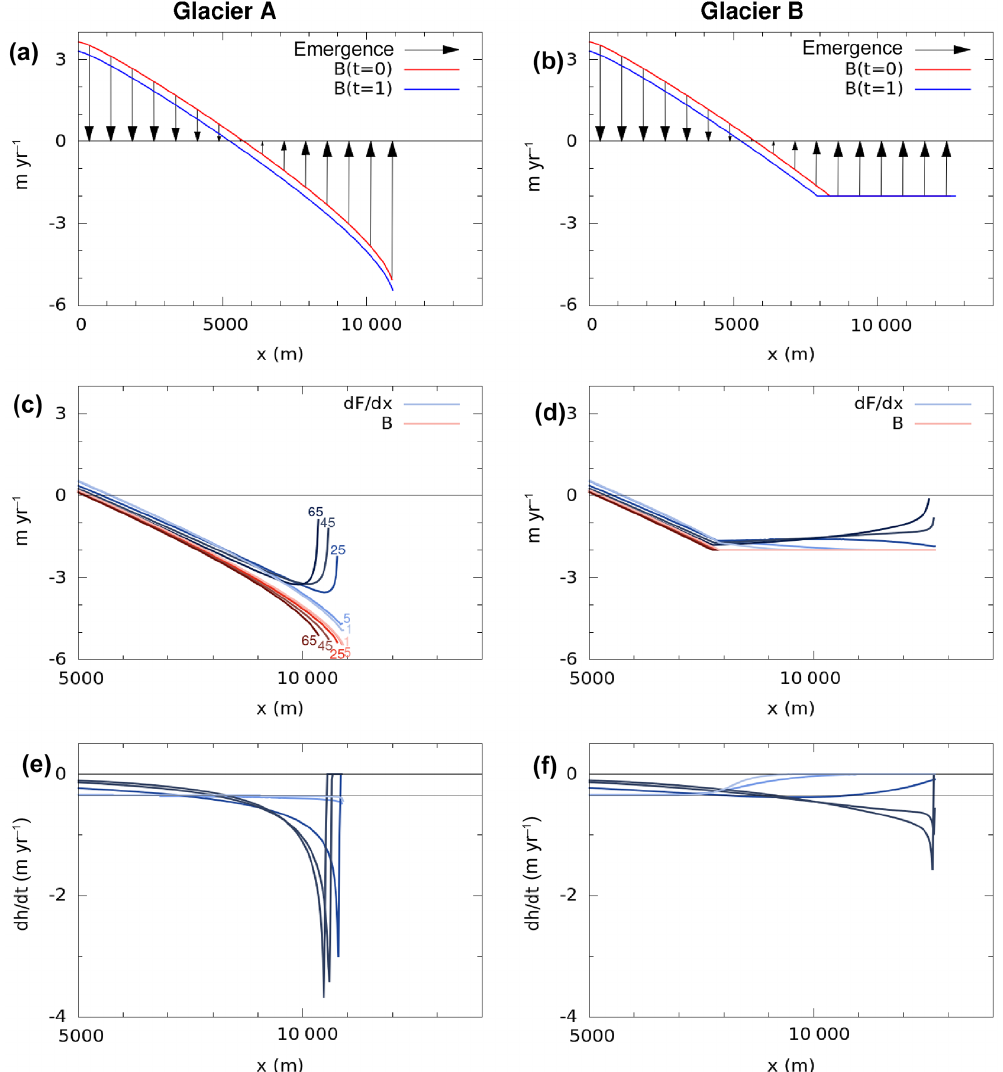
Figure 1. (a, b) The specific mass balance as a function of position for the initial steady-states of glaciers A and B (red lines). Black arrows denote the emergence velocities that balances the surface mass balance at t = 0. The blue lines are the surface mass-balance profiles a year after a step change in ELA by 50m (experiment 1). (c, d) The specific mass-balance (red lines) and flux-gradient (blue lines) profiles after 1, 5, 25, 45, and 65 years. In (c) the curves are labelled with the corresponding year. (e, f) The thinning rate profiles after 1, 5, 25, 45, and 65 years. Note the horizontal black thin lines at β(cid:49)E = 0 . 35myr − 1 (see text for details).